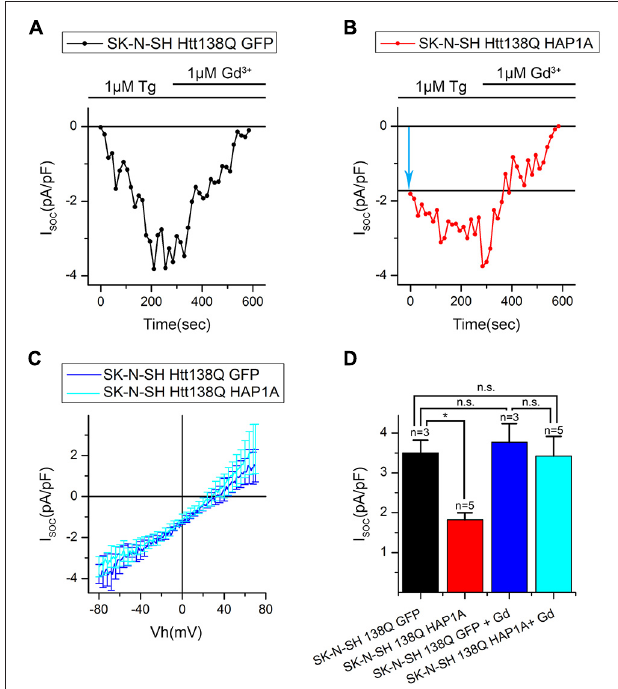
FIGURE 8 | Constitutive activity of SOC channels in SK-N-SH Htt138Q HAP1A. (A,B) Amplitudes of thapsigargin-induced store-operated calcium currents in SK-N-SH Htt138Q cotransfected with GFP ( A , black curve) or HAP1A ( B , red curve) at a test potential of − 80 mV plotted as a function of time. The times of thapsigargin and gadolinium application are indicated above the graphs. The level of the constitutive activity of SOC channels is indicated by the blue arrow in (B) . (C) Average current/voltage relationships (I/V curves) for gadolinium-sensitive currents in SK-N-SH Htt138Q cotransfected with GFP (dark blue curve) or HAP1A (light blue curve). The number of experiments is shown in (D) above the bars. (D) Average amplitudes of thapsigargin-induced currents in SK-N-SH Htt138Q cotransfected with GFP (black bar) or HAP1A (red bar) and gadolinium-sensitive currents in SK-N-SH Htt138Q cotransfected with GFP (dark blue bar) or HAP1A (light blue bar). Current amplitudes were determined at a test potential of − 80 mV and plotted as mean ± SEM. ∗ p < 0.05, significant difference in current amplitude. ns, not